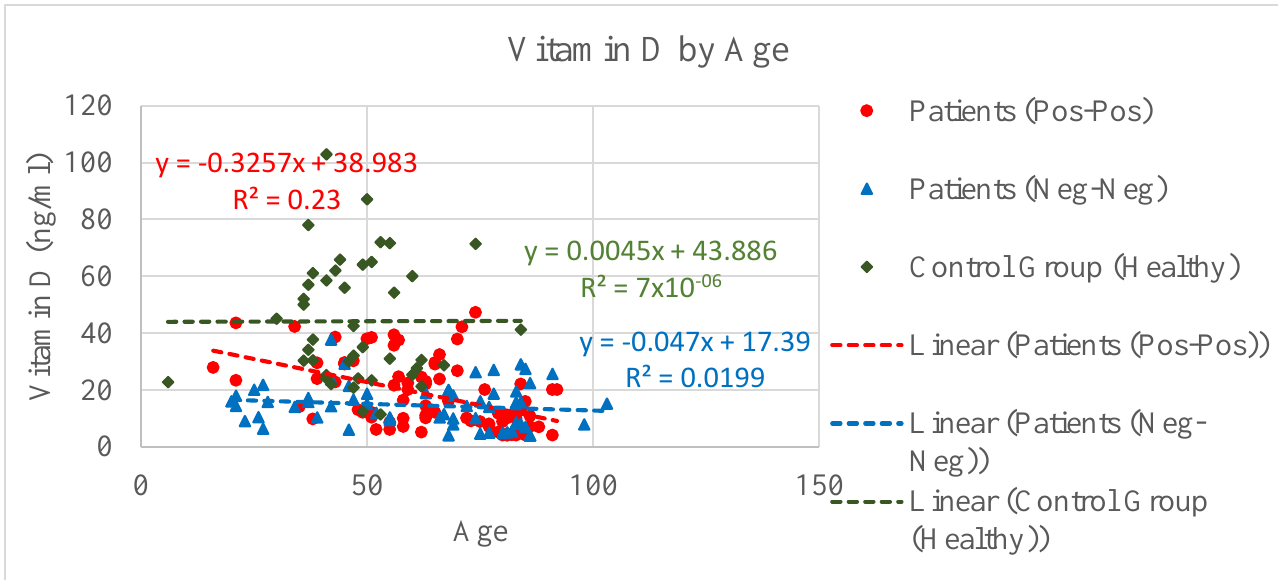
Figure 1. Scatter charts and regression lines for vitamin D levels by age for COVID-positive (PP) and COVID-free patients (NNp and healthy group NNh). The level of vitamin D is higher in the NNh group if compared to both PP and NNp. Of note, though both the PP and NNp groups show a low level of vitamin D, the trend is quite different. While the latter shows a linearity of vitamin deficiency independently from the age, a phenomenon probably connected with chronicity of the disease, the PP group showed a decline of vitamin D strictly dependent on the age; the drops from low to very low based on the age are very clear and are suggestive of an acute pattern of the disease.